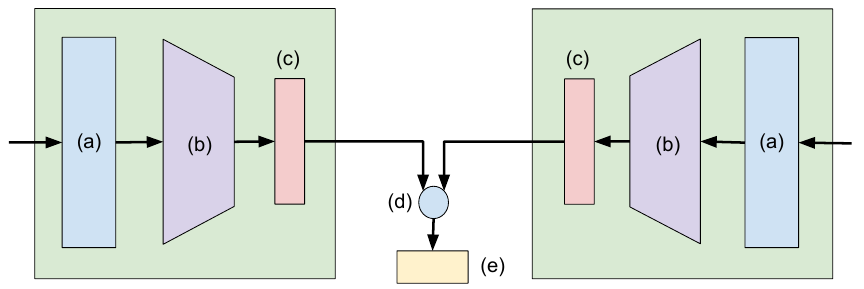
Figure 9. Siamese Neural Network with two identical subnetworks. ( a ) Input ( b ) Convolutional Neu- ral Network layers ( c ) Fully connected—sigmoid layer ( d ) Absolute difference ( e ) Fully connected— sigmoid